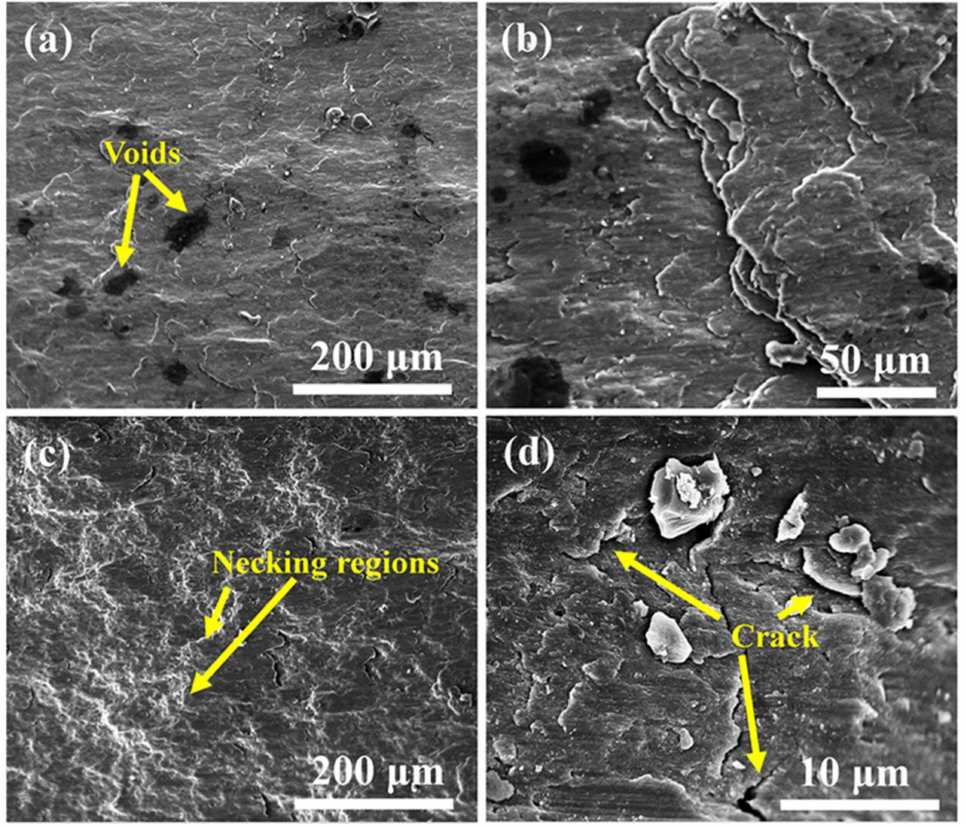
Figure 12. Fracture surface of samples tested under compression: ( a , b ) S20 and ( c , d )